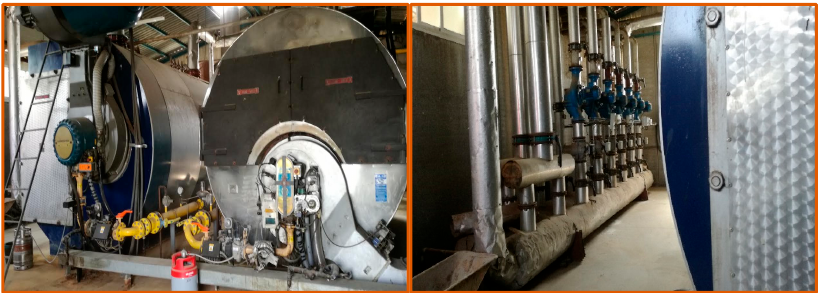
Figure 6. Boilers and water vapor injectors.